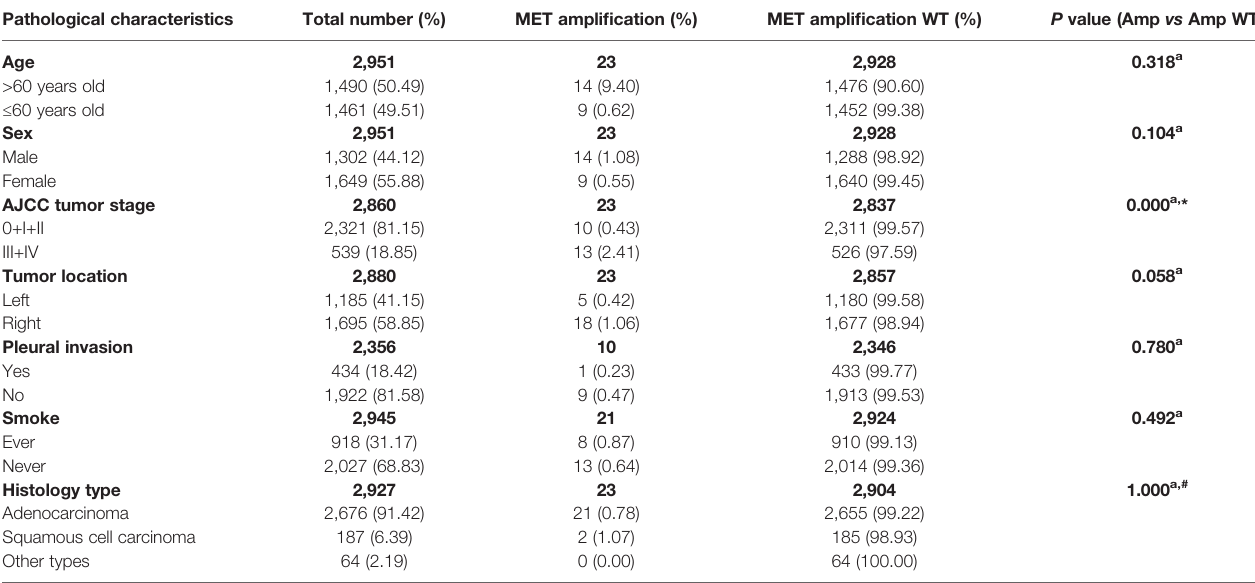
TABLE 3 | Clinicopathological characteristics and MET ampli fi cation. Pathological